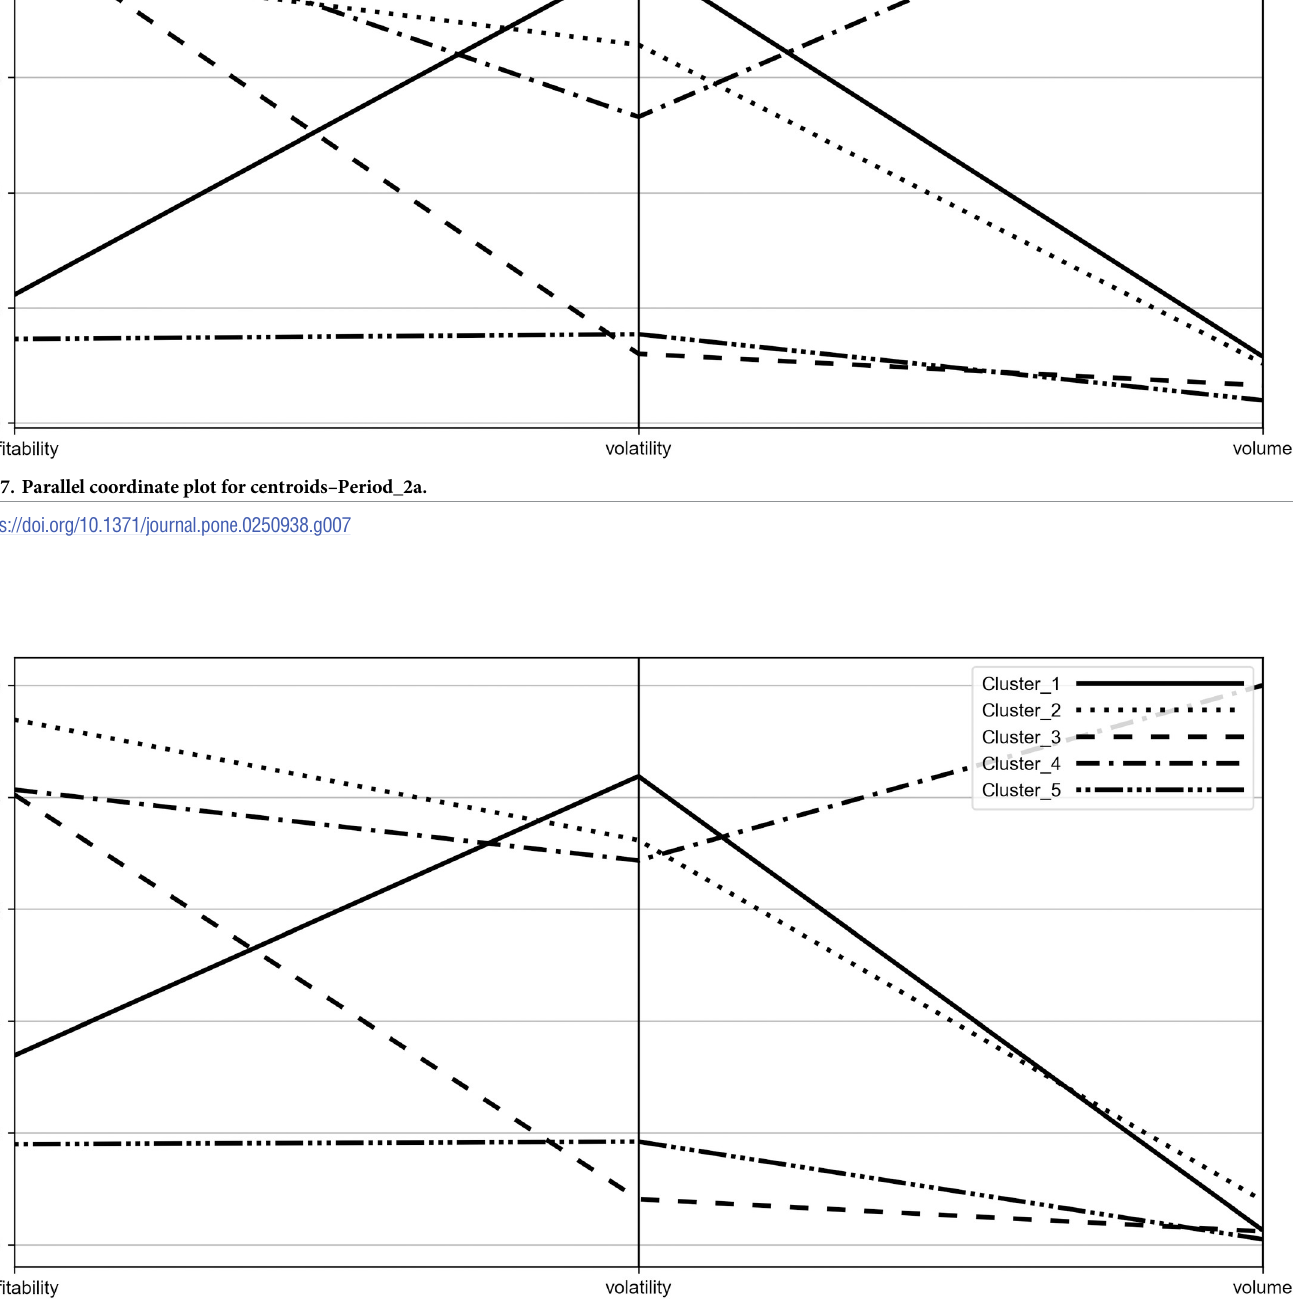
PLOS ONE | https://doi.org/10.1371/journal.pone.0250938 May 20,